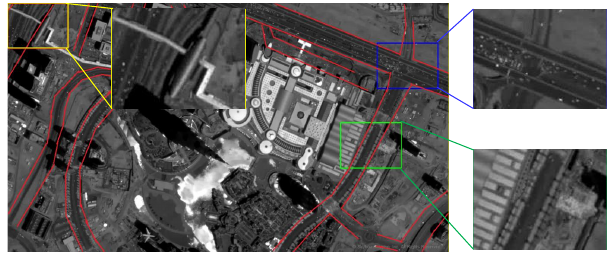
Figure 5. The original image with road boundary marked in red and three regions in bounding boxes are chosen to explain our method.